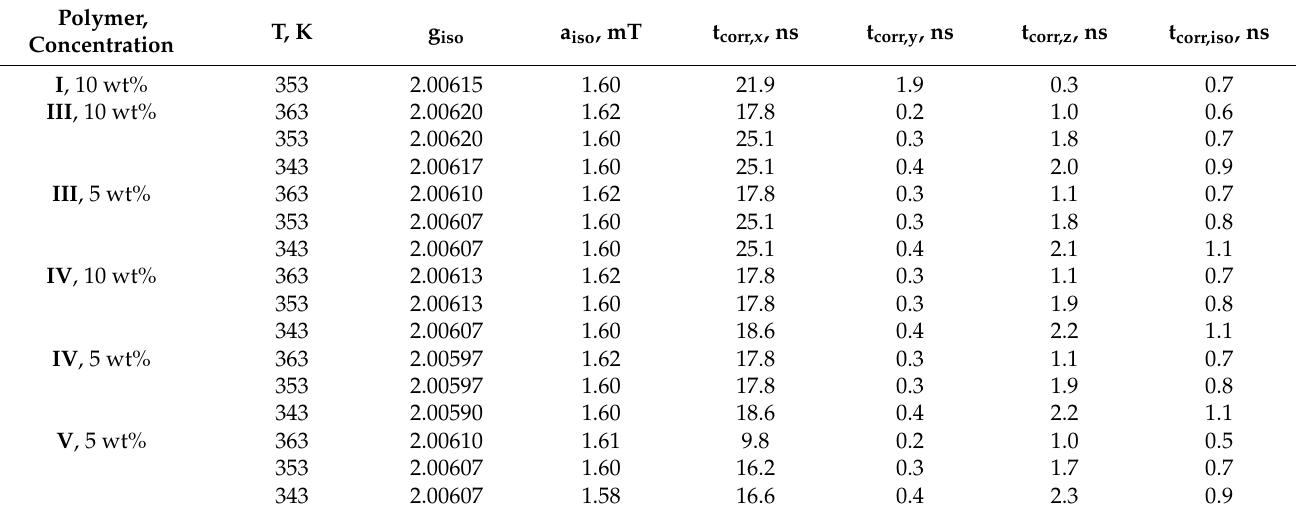
Table A1. Selected spectral parameters from simulation TEMPO EPR spectra in 5 and 10 wt% solutions in the presence of a quencher at 343–363 K.